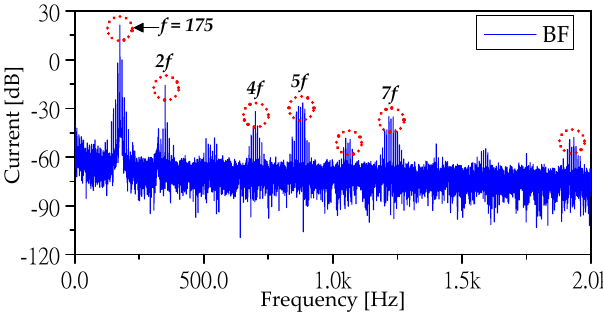
Figure 9. Frequency spectrum of the stator current under BF.